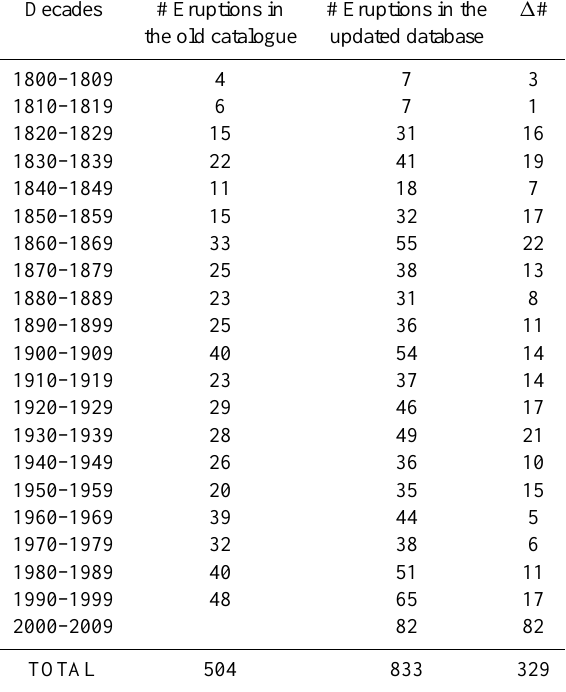
Table 1. The number of eruptions of the Andean belt from 1800 to 2010 subdivided by decades. A comparison is made between the old Smithsonian Institution Database (Siebert et al., 2011) and the new updated data mainly used in this study. In the column on the right the difference between the new and old decadal values is